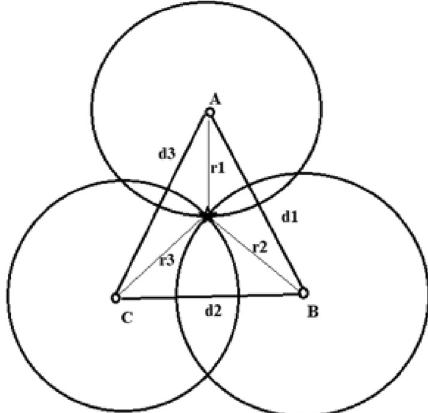
Fig. 7 The reduced intersection point of the circles A, B and